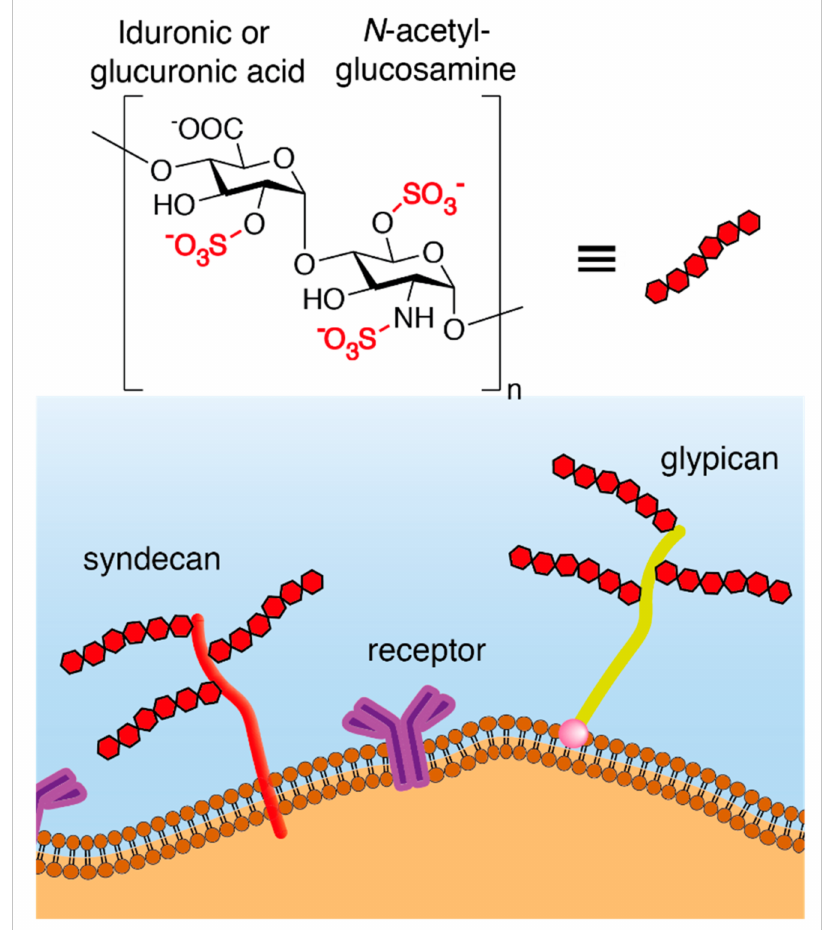
Figure 1. Schematic structure of syndecans and glypicans, the two HSPG chiefly involved in virus infection. HSPG typically consist of a core protein and GAG chains. The core protein of syndecans is composed of an extracellular domain, a single transmembrane domain, and a short cytoplasmic domain that interacts with the cytoskeleton. Glypicans are GPI-anchored HSPG. The GAG chain is composed of unbranched anionic polysaccharides composed of repeating disaccharide units formed by sulfated uronic acid and hexosamine